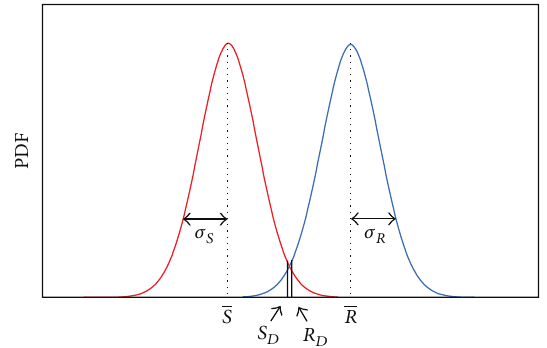
Figure 1: Load-resistance model for structural reliability assess- ment.